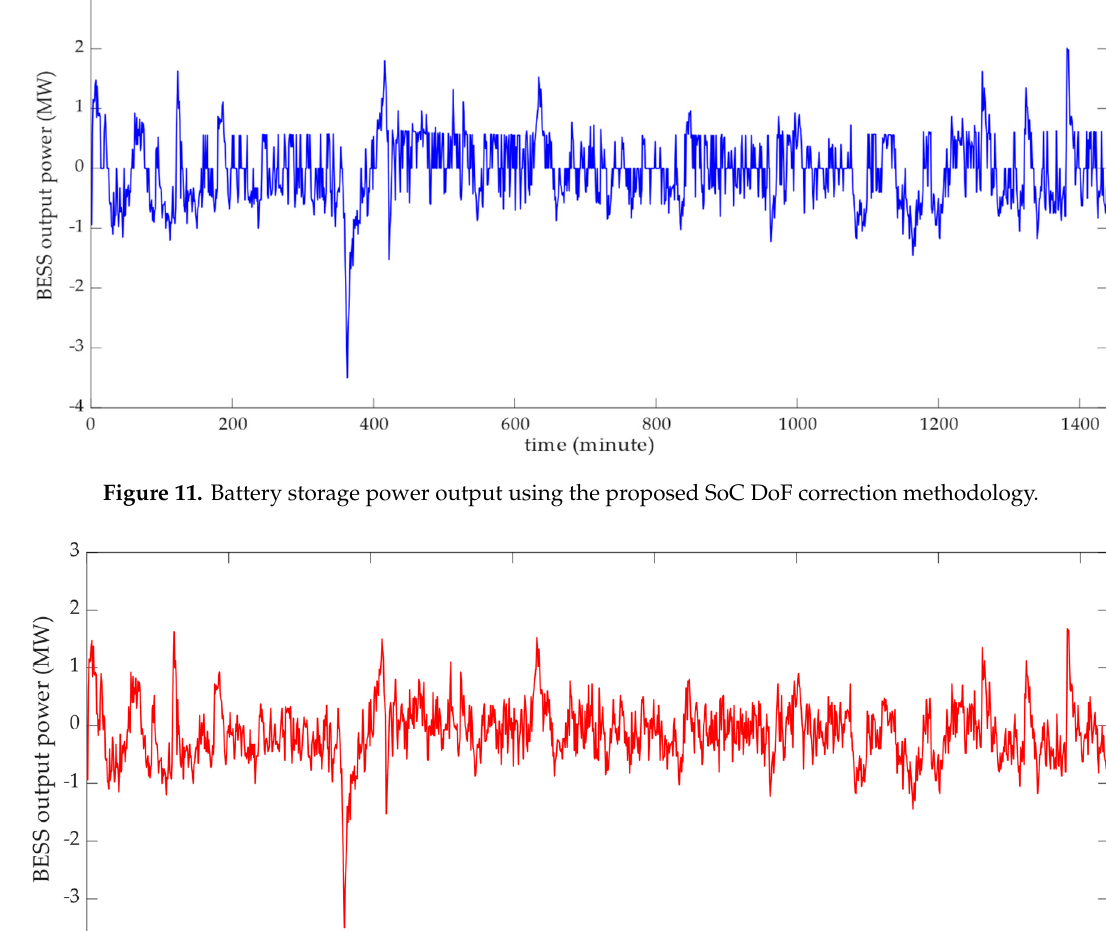
Figure 13. Differential power between the BESS operation with activated control strategies and without control strategies.